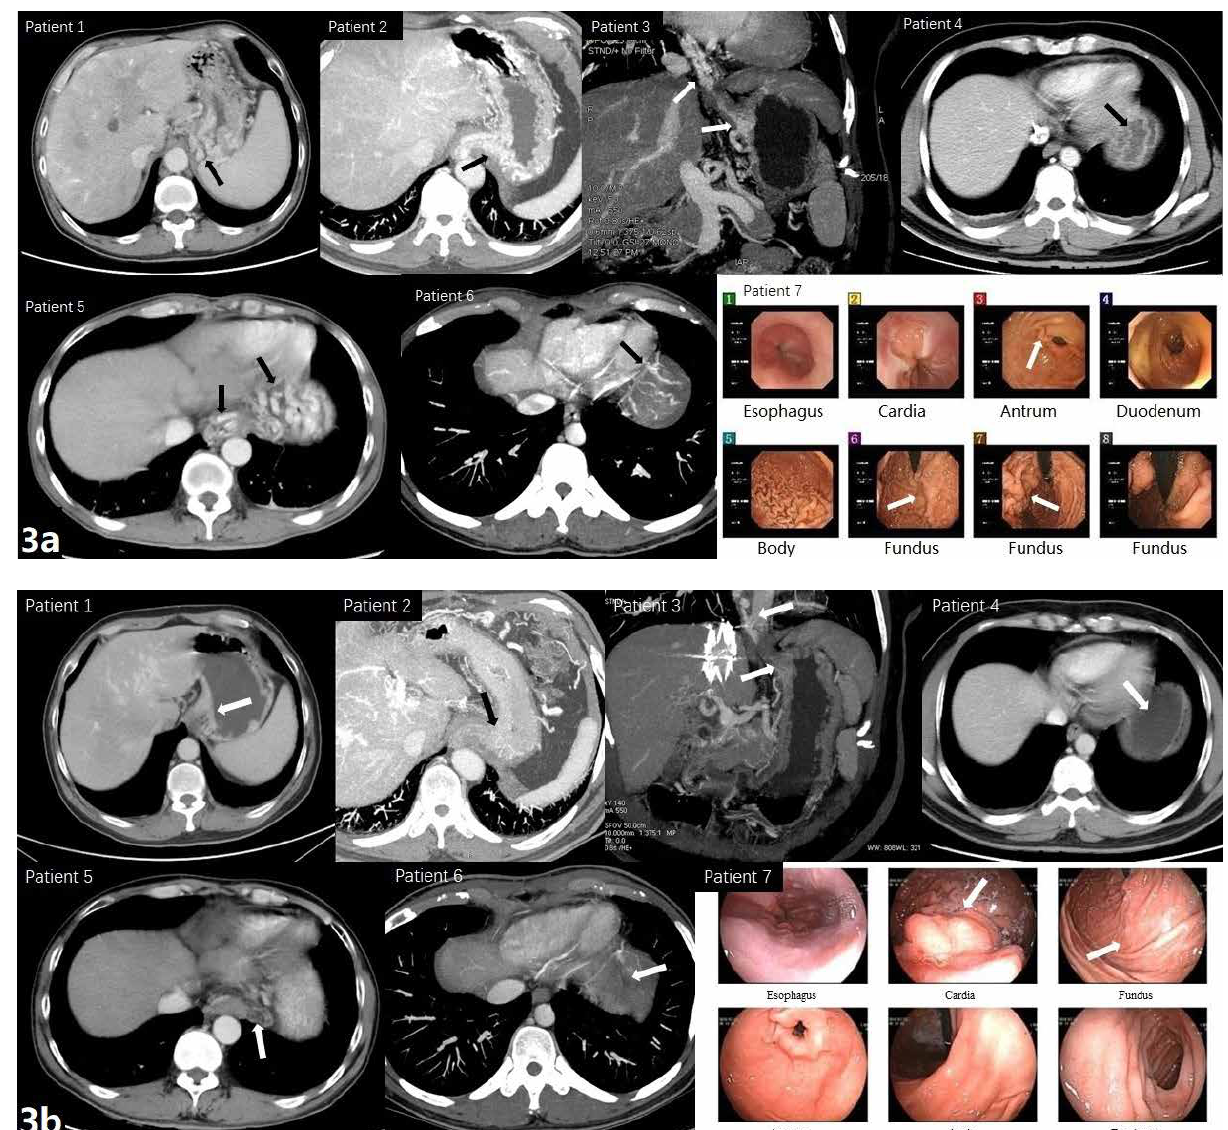
Figure 3: Preoperative and reviewed enhanced CT or endoscopy images. a) Gastroesophageal varices at preoperative enhanced CT or endoscopy in 7 patients (arrows). b) Enhanced CT or endoscopy review of the 7 patients showing obviously decreased or eradicated gastric varices in all patients but residual esophageal varices in patient 3,4,5 and 7 after procedure